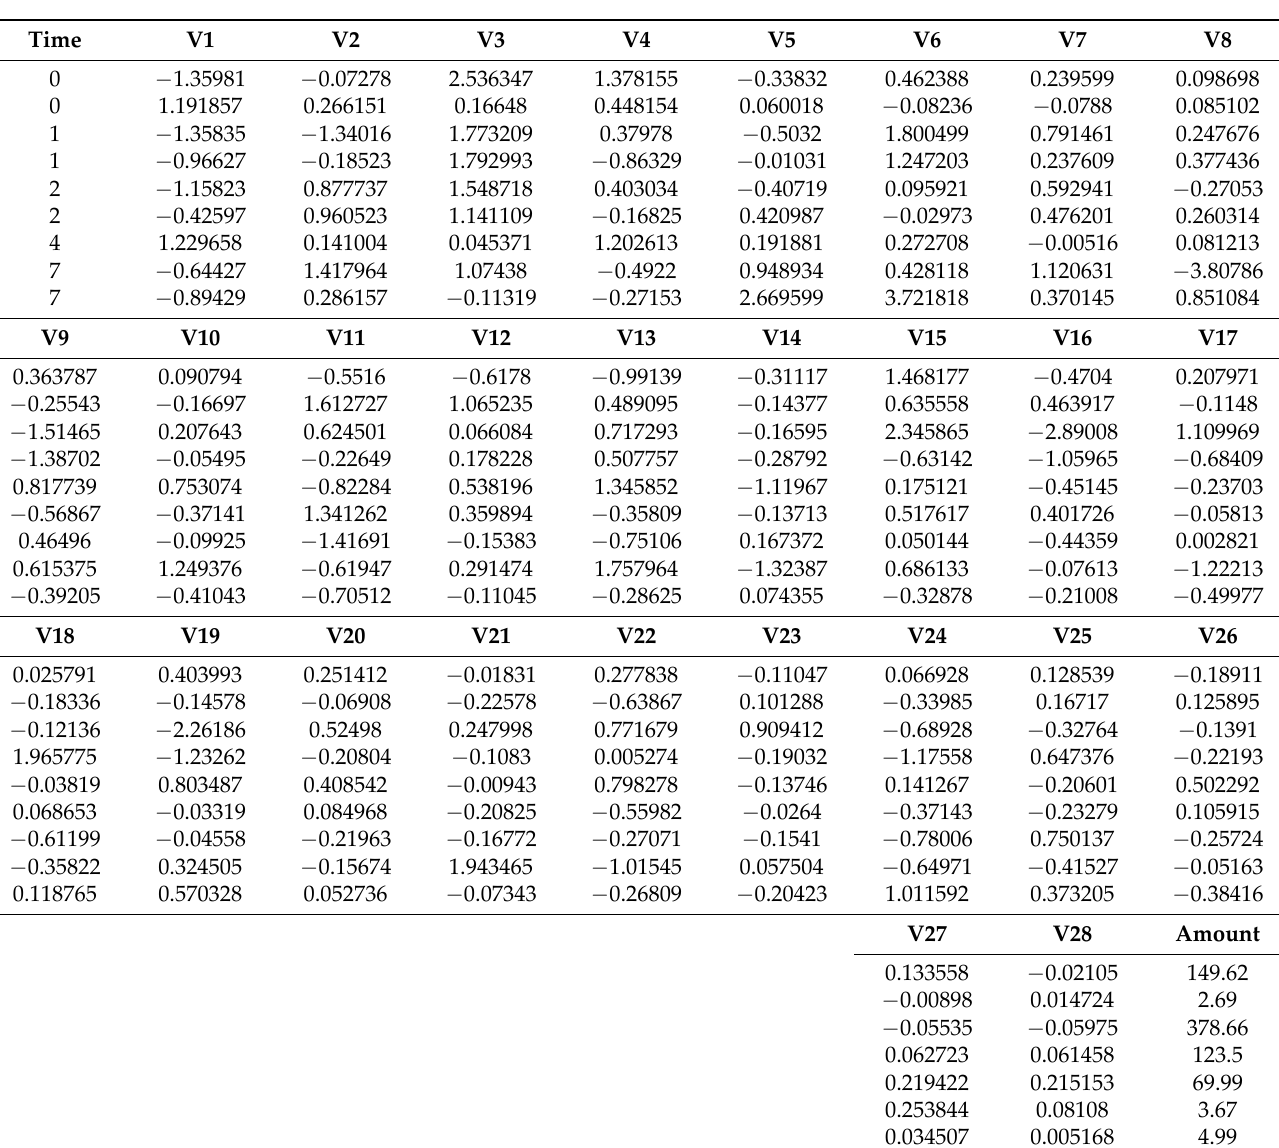
Table 2. Credit card dataset features (highlighted in bold) (first samples of